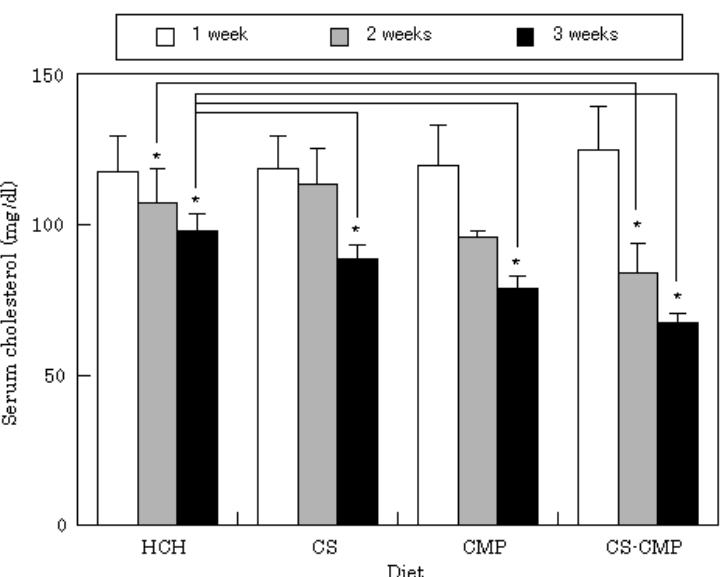
Figure 2. Changes in total serum